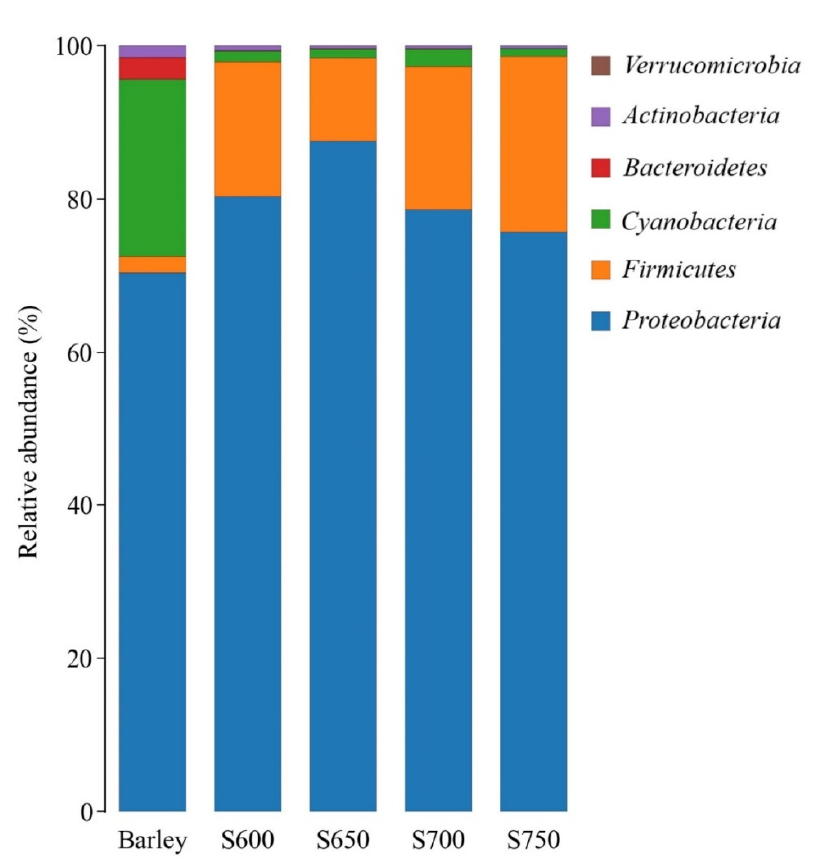
Figure 1. Bacterial community found in fresh barley and silages at the phylum level ( n = 3). S600, S650, S700, and S750 represent silages densities of 600, 650, 700, and 750 kg/m 3 , respectively. The bacterial composition in the fresh barley and silages at genus levels is displayed in Figure 2. In the fresh barley, the dominant bacterial genera were Pantoea (30.4%), followed by uncultured bacterium (26.9%), and uncultured bacterium _f_ Burkholde (12.0%). However, Lactobacillus was almost undetectable in fresh barley (<1%). After fermentation, the genus Enterobacter predominated in all silages. As silo density increased, the relative abundance of Enterobacter decreased from 47.4% to 35.4% and that of Clostridium de- creased from 13.5% to 3.8%. In contrast, Lactobacillus abundance increased to 17.0% in the S750 silage as compared with 1.8% in S600 silage. Kosakonia and Pantoea were found in high abundance (6.9–31.0% and 6.0–12.6%, respectively) in all silages. Uncultured bacte-